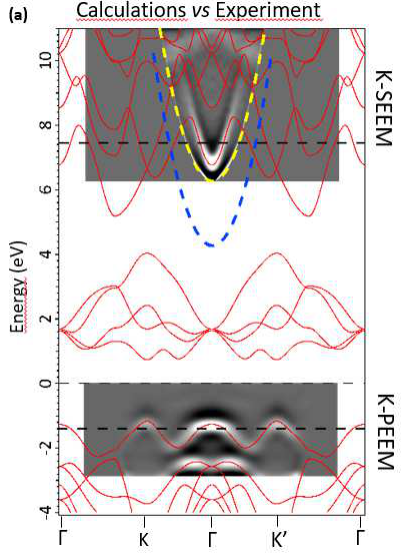
Figure 4. Calculated occupied and unoccupied electronic states and corresponding experimental k-PEEM. E-k cuts through K- Г -K’ as shown by horizontal, white dashed lines in Figure 3 (a,